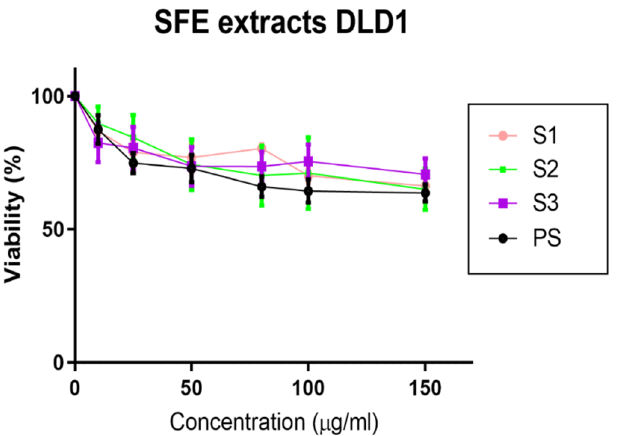
Figure 3. Effect of the supercritical extracts on cell viability (MTT assay) of DLD1 colorectal cancer cells. Dose–response curves of the cell proliferation assay after 48 h of treatment with increasing concentrations of MB SFE extracts. Data represent mean ± SEM of three independent experiments, each performed in triplicate.